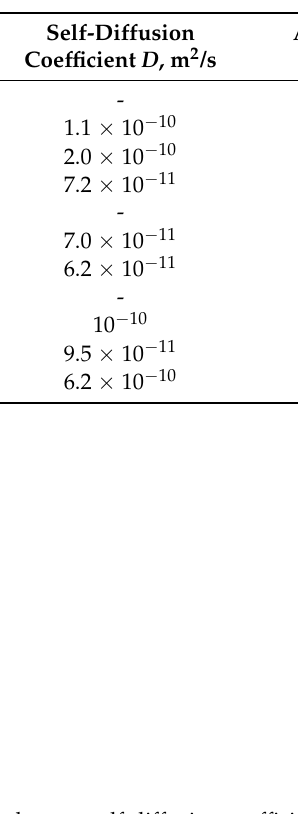
Figure 41. Dependencies of the F − counterion and water self-diffusion coefficients on the concentra- tion of the outer contacting electrolyte (aqueous solution of NH 4 F × HF), curves 1 and 2, respectively. Curves 1’ and 2’ are the F − ion and water self-diffusion coefficients in an aqueous solution of NH 4 F × HF ( T = 300 K).